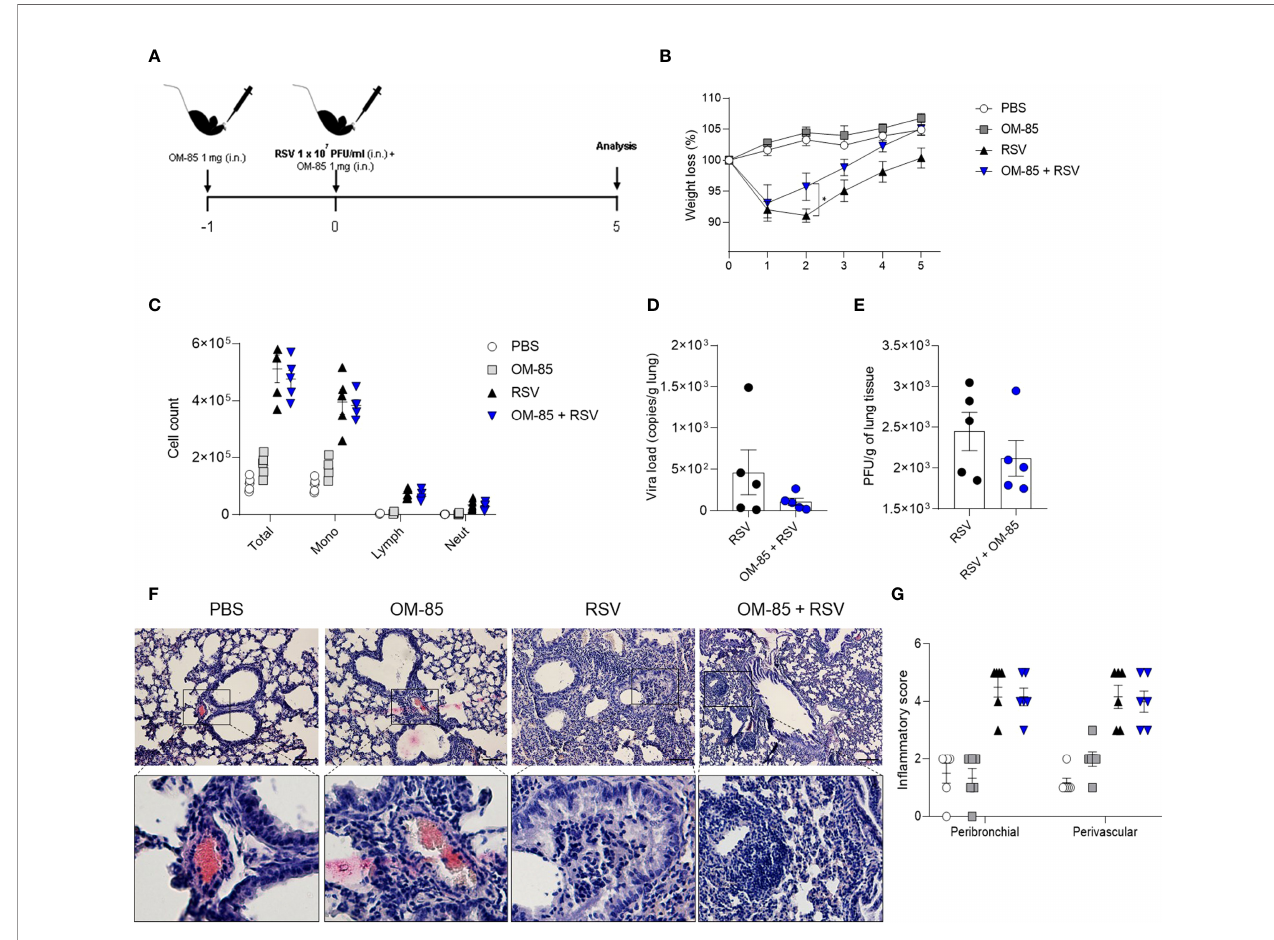
FIGURE 2 | Short – time preventive treatment with OM – 85 protects against weight loss caused by RSV infection. Mice were treated intranasally with OM – 85 (1mg) 1 day prior to RSV infection. Afterwards, mice were infected with RSV (1x10 7 PFU/ml) and received another OM – 85 boost 6h later. (A) Experimental design. (B) Percentage of weight loss relative to day 0 (right before infection). (C) Total cell number and differential cell counts in BAL. (D) RSV viral load detected in lung tissue by real – time PCR (viral copies/g of lung tissue). (E) Viral titer in the lung (PFUs/g lung tissue). (F, G) Representative images of lung tissue section stained with H&E and its respective in fl ammation scores. Scale bars=200 m m. Data from 2 independent experiments (n = 6 per group). All data are expressed as mean±SEM. Multiple groups were compared using Kruskal – Wallis, except in (D, E) in which the comparison between groups was made using Mann – Whitney test. * p